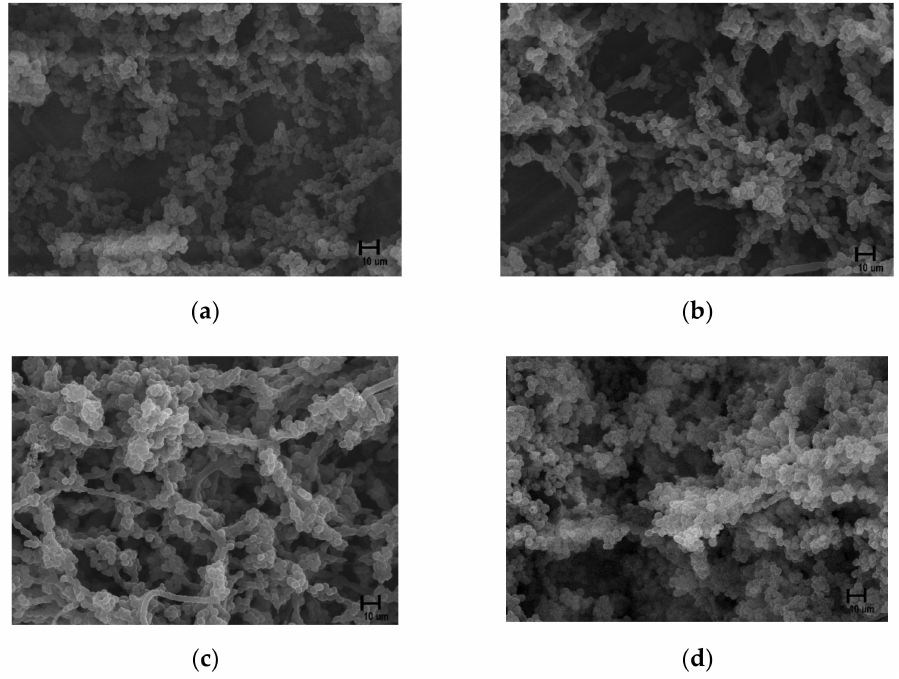
Figure 8. Field emission-scanning electron microscopy images of P. gingivalis cultured for 48 h after non-thermal plasma treatment in the ( a ) control group, ( b ) 60 s group, ( c ) 300 s group, ( d ) 600 s group ( ×